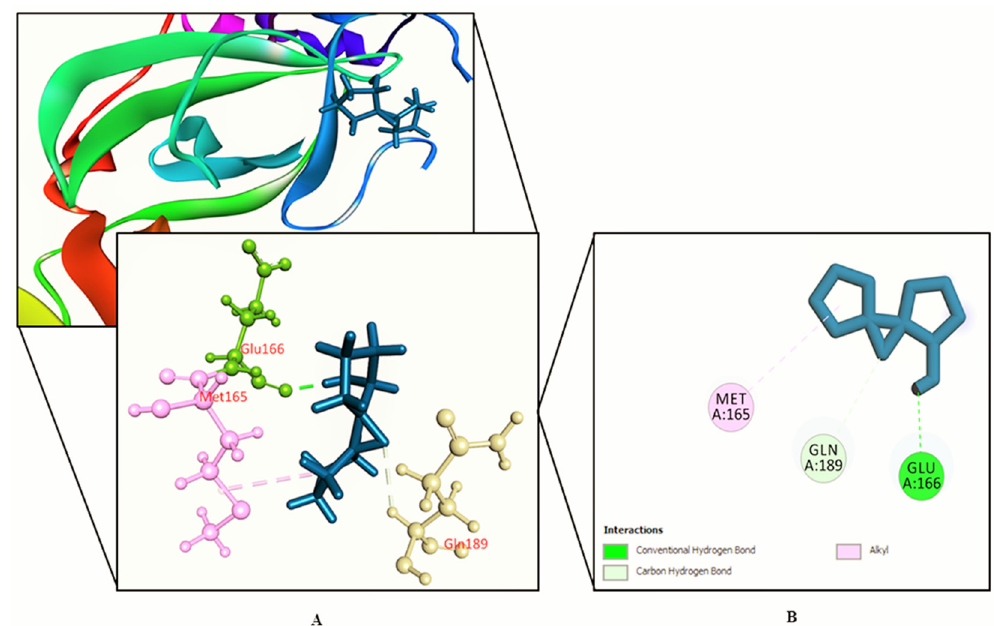
Figure 2. Shown here is 11-oxa-dispiro[4.0.4.1]undecan-1-ol binding the SARS-CoV-2 receptor (PDB ID: 6LU7). ( A ) A 3D representation and ( B ) 2D representation. Hydrogen bonds are displayed as green balls and sticks, hydrophobic bonds (Pi–Pi/Pi–sigma/amide–Pi interactions) are displayed as violet balls and sticks, hydrophobic bonds (Pi–alkyl/alkyl interactions stacking) are displayed as pink balls and sticks, hydrophobic bonds (Pi–sulfur) are displayed as gold balls and sticks, and carbon–hydrogen bonds are displayed as white balls and sticks.